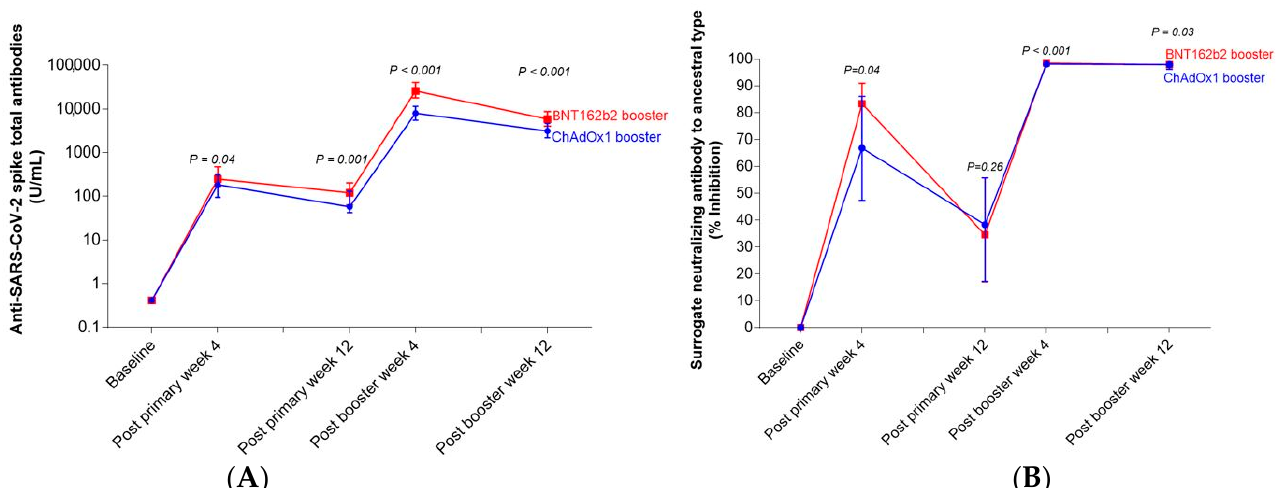
Figure 1 . Dynamic of immune response of participants who received primary CoronaVac vaccination and were boosted with BNT162b2 or ChAdOx1 at week 12 for ( A ) anti-SARS-CoV-2 spike total antibodies (U/mL) by Elecsys and ( B ) surrogate neutralizing antibody to ancestral type (% inhibition) by GenScript at 4 and 12 weeks post booster .